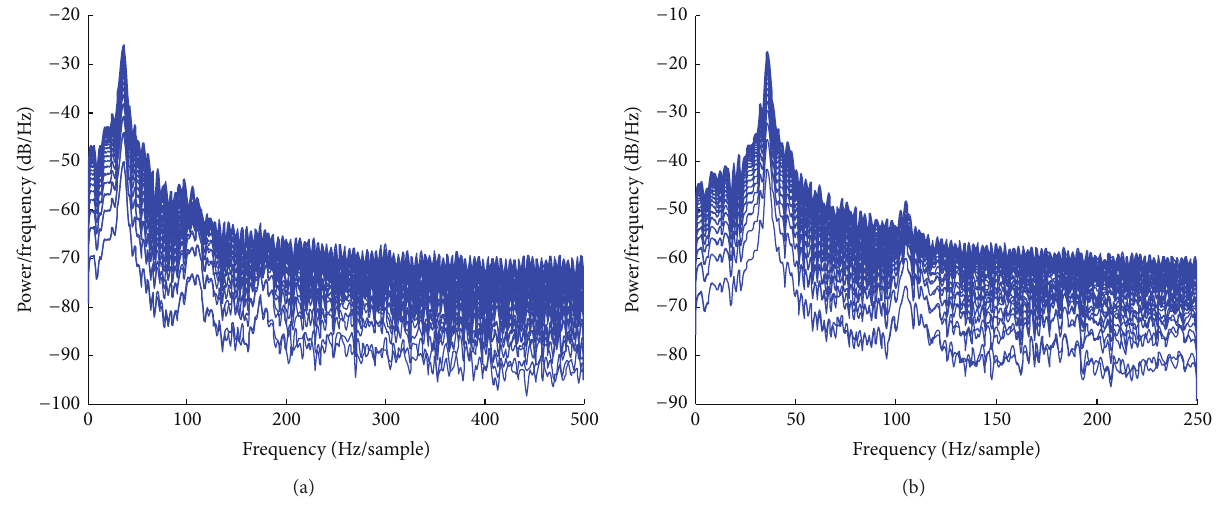
Figure 4: PSE curves: (a) Fr = 1.0 Hz, (b) Fr = 0.5